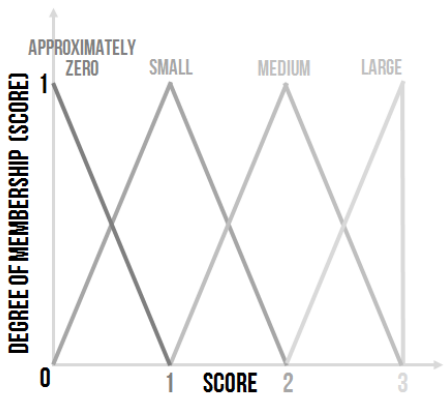
Figure 7. The shape of the membership functions of linguistic values for the output linguistic variable Score